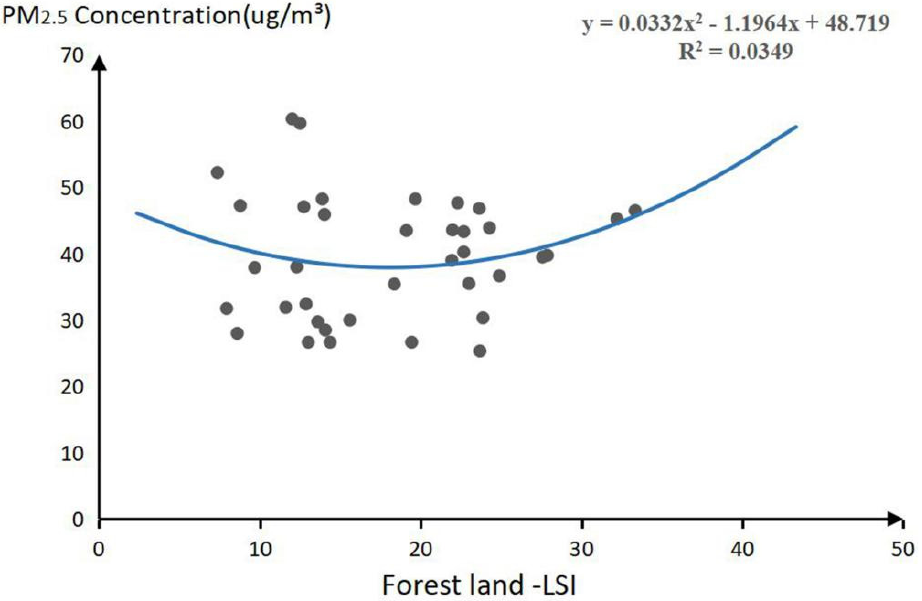
Figure 1. Threshold of significant landscape pattern indices for PM 2.5 pollutant.